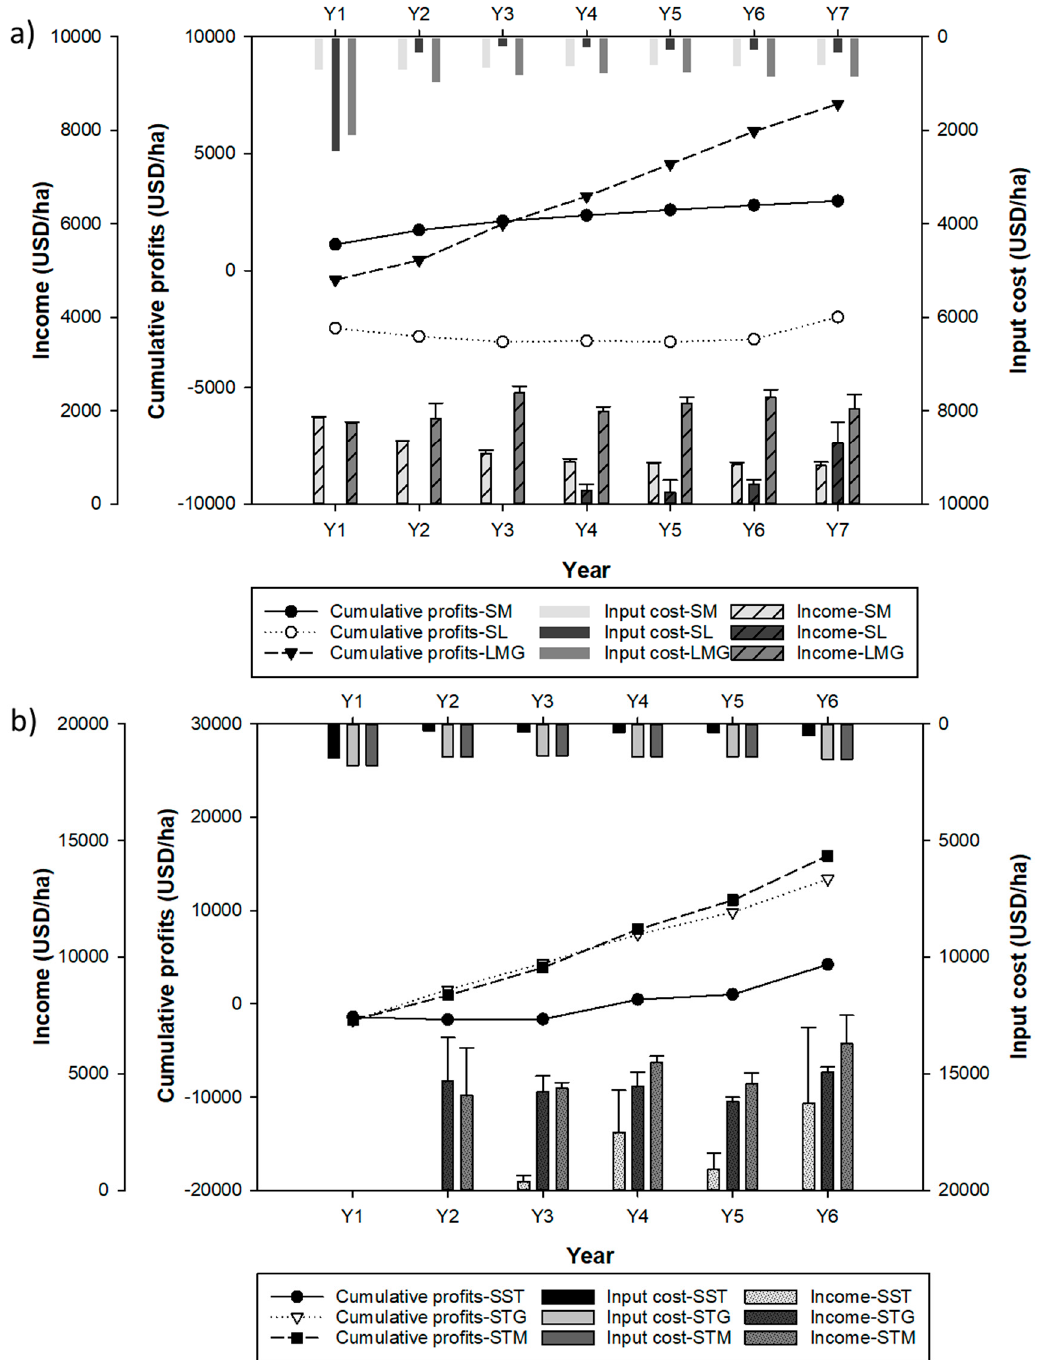
Figure 6. Input costs, income, and cumulative profit from: ( a ) the longan–maize–forage grass (LGM) compared with sole maize (SM) and sole longan (SL); ( b ) the son tra–guinea grass (STG) and son tra–mulato grass (STM) compared with sole son tra (SST). Table 3. Net profit from the agroforestry systems and the corresponding sole crop/tree.